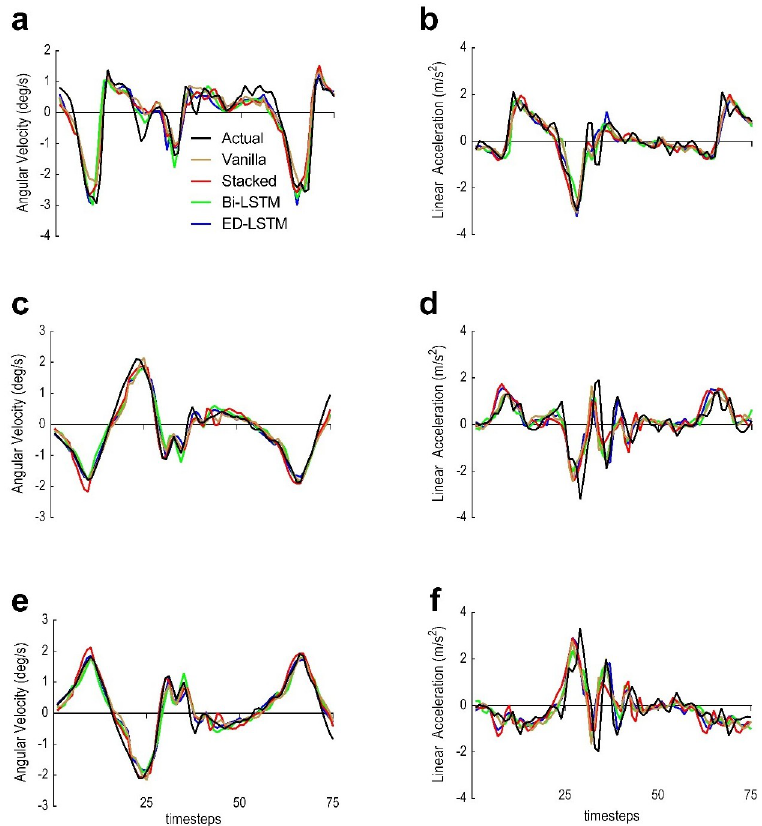
Fig 4. LSTM models prediction performance based on the inter-subject test for each feature vector at PWS only. Models were tested with 75 time-steps and the same participant was tested across LSTM models. Black is the actual trajectory. Brown is the Vanilla LSTM predicted trajectory. Red is the Stacked LSTM predicted trajectory. Green is the Bi-LSTM predicted trajectory. Blue is the ED-LSTM predicted trajectory. (a) Foot AV ( X 1 ). (b) Foot LA ( Y 4 ). (c) Shank AV ( X 2 ). (d) Shank LA ( Y 5 ). (e) Thigh AV ( X 3 ). (f) Thigh LA ( Y 6